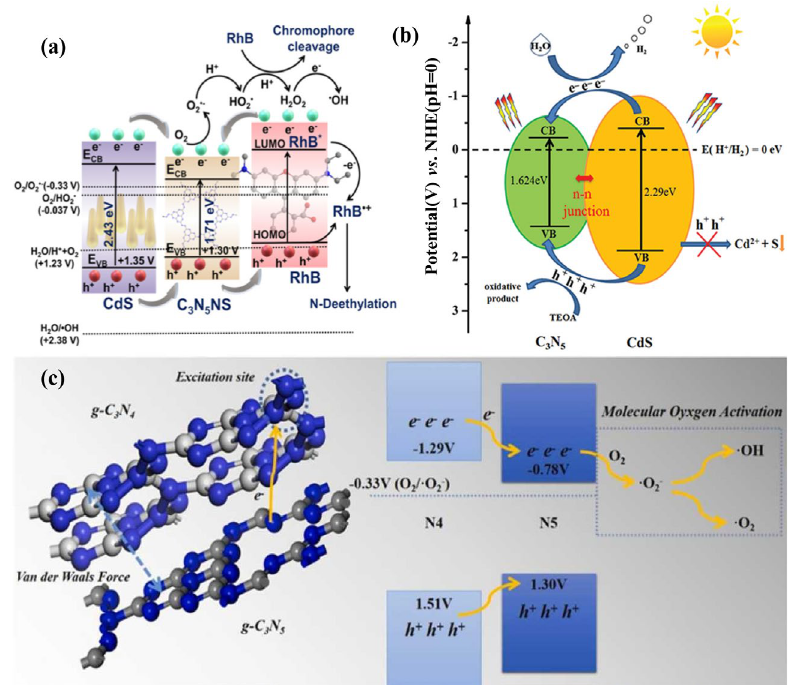
Figure 11. ( a ) CdS/C 3 N 5 for RhB degradation; ( b ) CdS/C 3 N 5 for H 2 evolution; ( c ) g-C 3 N 4 /g-C 3 N 5 for RhB and TC-HCl. ( a ) Adapted with permission from [53]. Copyright American Chemical Society, 2021. ( b ) Adapted with permission from [54]. Copyright Informa UK Limited, trading as Taylor and Francis Group, 2022. ( c ) Adapted with permission from [55]. Copyright Elsevier B.V., 2022.